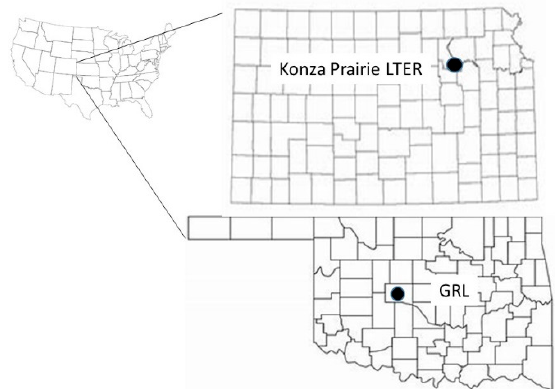
Figure 1. Study sites located at the Konza Prairie Long-Term Ecological Research (LTER) site near Manhattan, Kansas, and the United States Department of Agriculture-Agricultural Research Service’s Grazinglands Research Laboratory (GRL) in El Reno, Oklahoma, USA.